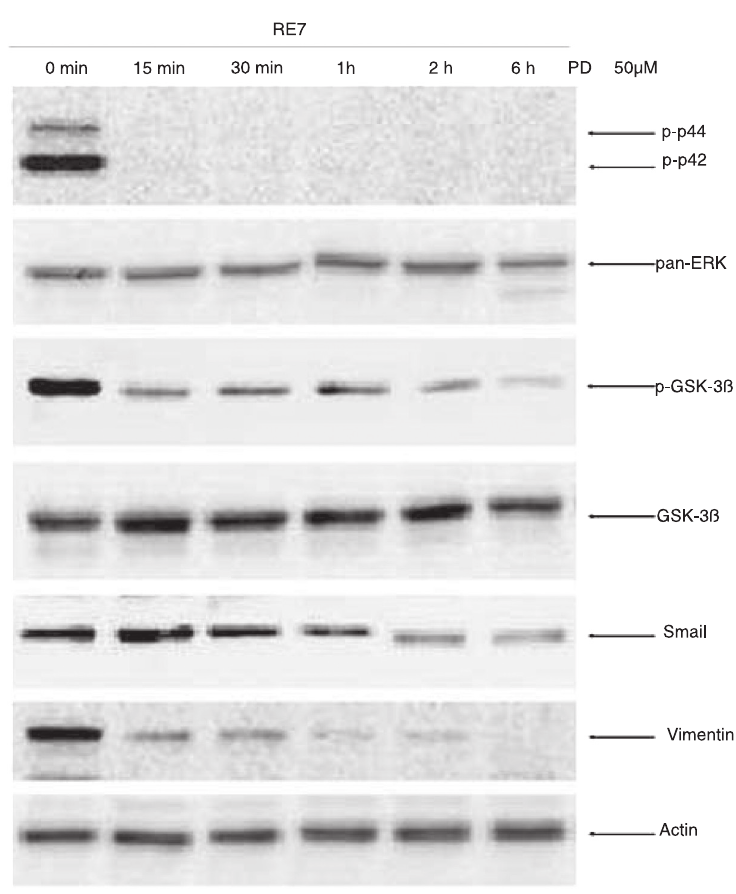
Figure 6. Inhibitory effect of PD98059 on macrophage stimulating protein (MSP)- stimulated RE7 cells. RE7 cells were stimulated with 2 nM MSP in the presence of individual chemical inhibitors such as PD98059 (PD, 50 μM) for 0-6 h. Cellular proteins from RE7 cells were probed in Western blots with 5 antibodies specific for the signaling molecules ERK, p-GSK-3β, GSK-3β, Snail, and